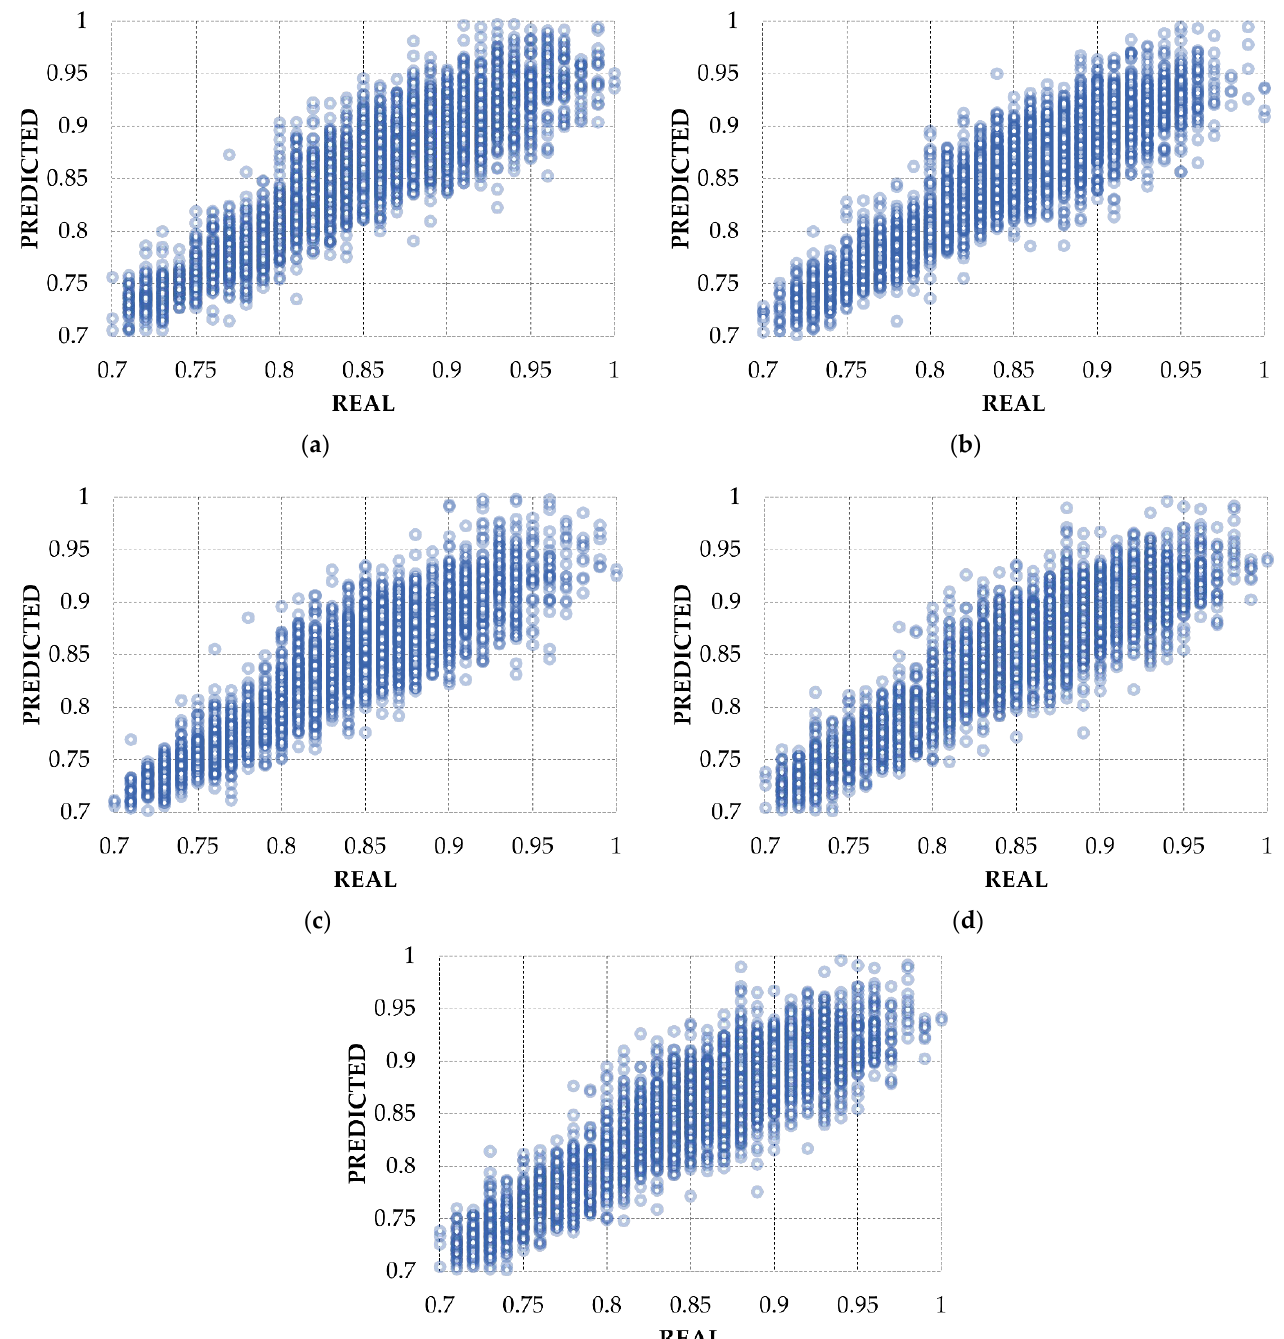
Figure 6. Comparison curve of model predicted values and real values of the relative pump speeds for Network 2. ( a ) PU2, ( b ) PU4, ( c ) PU6, ( d ) PU8, ( e ) PU10.